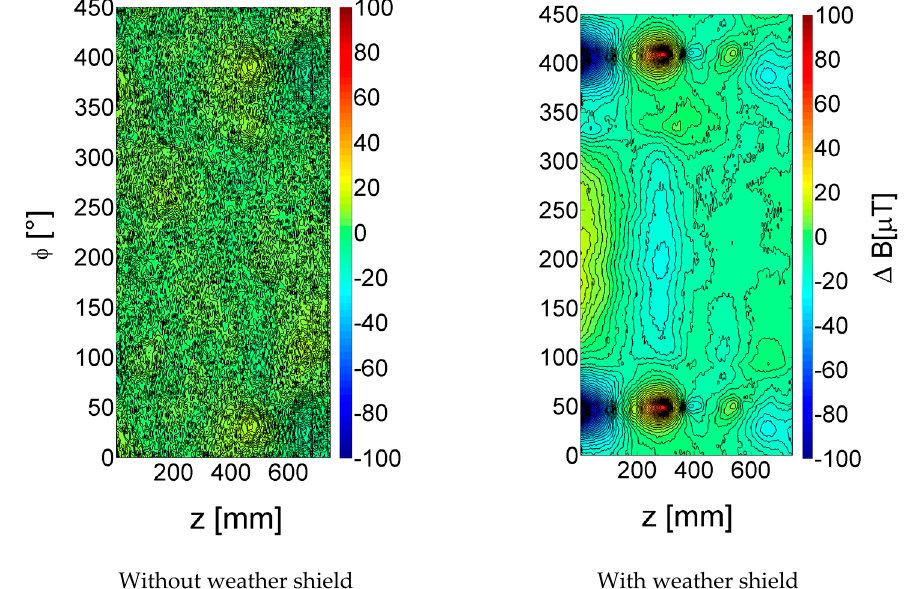
Figure 6. Change in magnetic field amplitude ( r -sensor) without (left) and with (right) 0.5 mm thick aluminium weather shield; 20 Hz, 300 A excitation frequency.